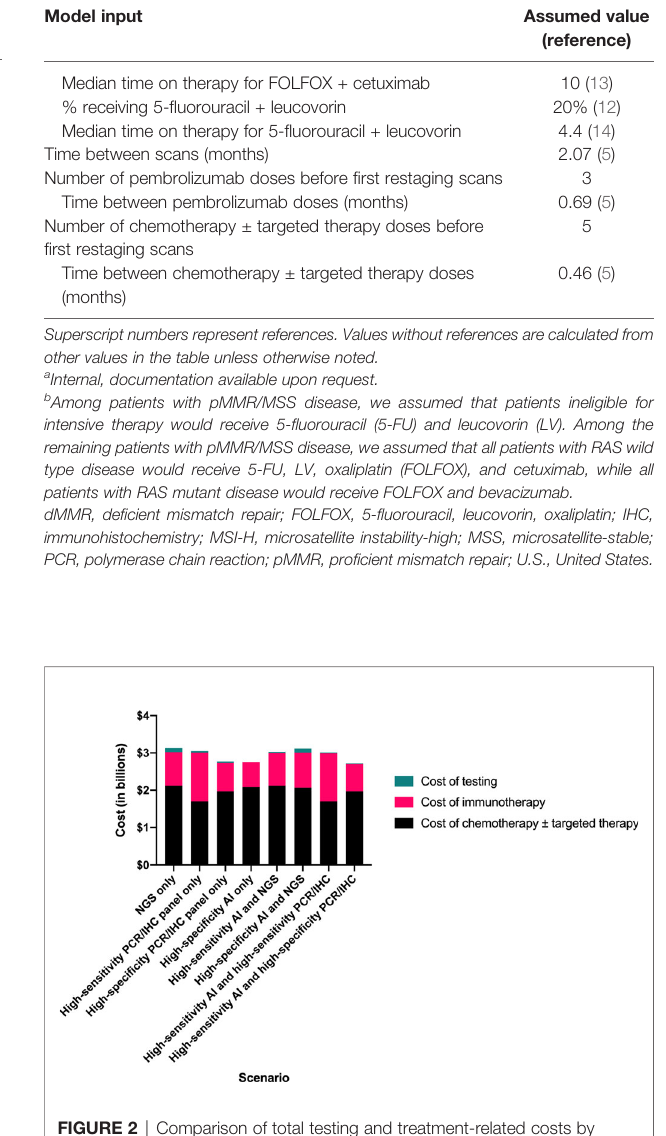
FIGURE 2 | Comparison of total testing and treatment-related costs by clinical scenario. AI, arti fi cial intelligence; IHC, immunohistochemistry; NGS, next-generation sequencing; PCR, polymerase chain